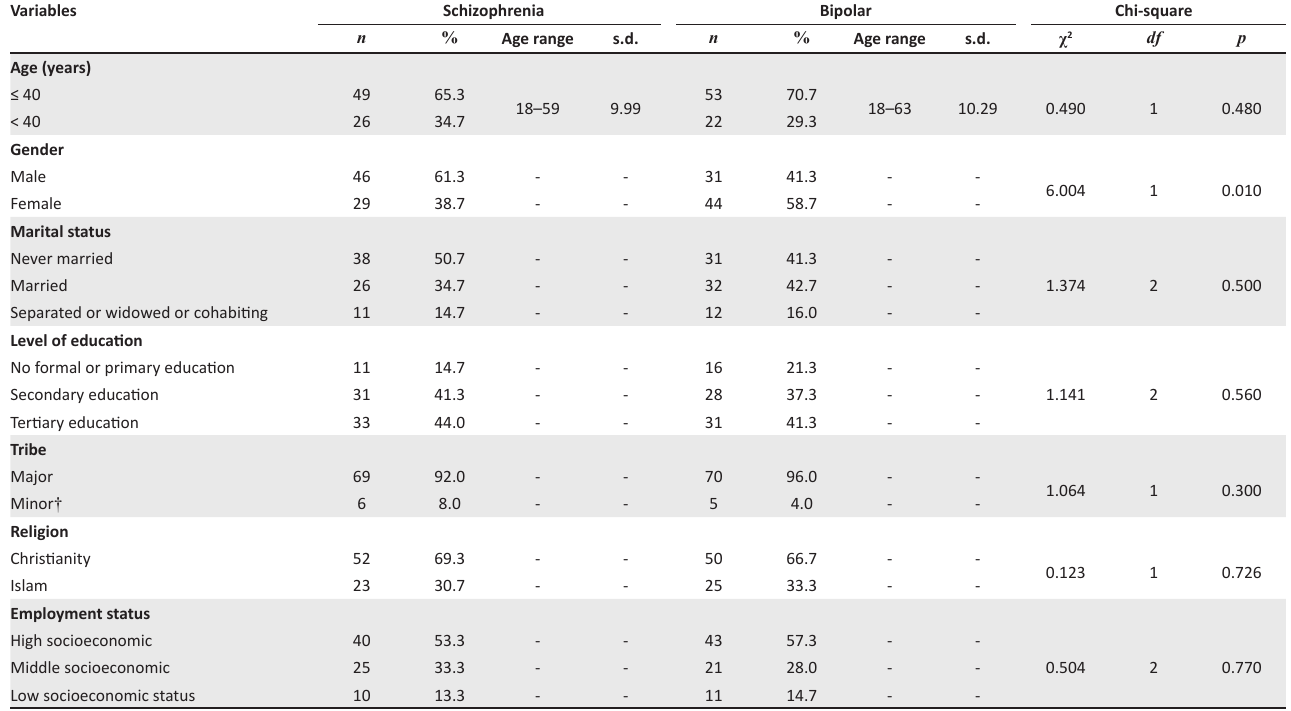
TABLE 1: Sociodemographic characteristics of respondents ( n =